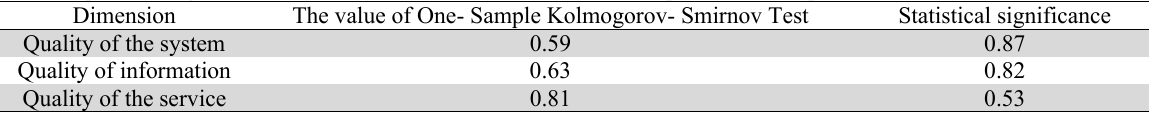
One- Sample Kolmogorov- Smirnov Test on the dimensions of the independent and dependent variables Dimension The value of